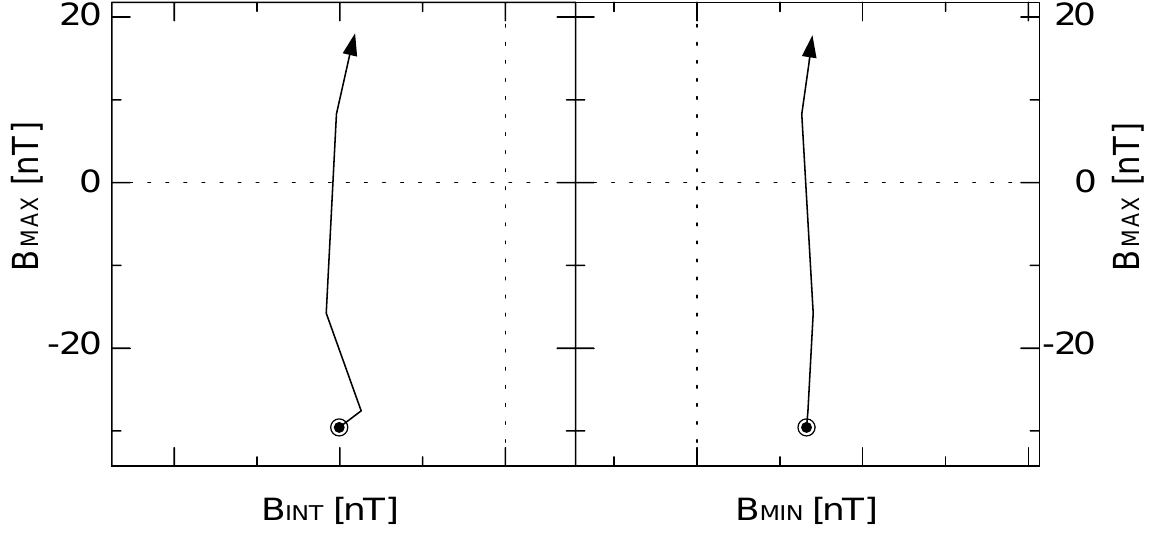
Fig. 6. Hodogram pair from minimum variance analysis (MVAB) of prime-parameter magnetic field in the portion of the magnetopause cross- ing by C1, chosen to maximize the eigenvalue ratio λ 2 /λ 3 . The eigenvalues of the variance matrix are λ 1 = 358, λ 2 = 2 . 25, and λ 3 = 0 . 245nT 2 . The predicted normal vector forms an angle of more than 60 ◦ with the bull’s-eye normal in Fig. 5. The normal field component is 13.4nT. In spite of the good eigenvalue separation, the predicted normal is a poor